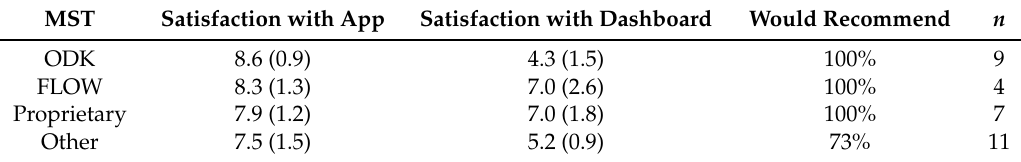
Table 6. Mean level of satisfaction by MST used: score out of 10 (standard deviation).